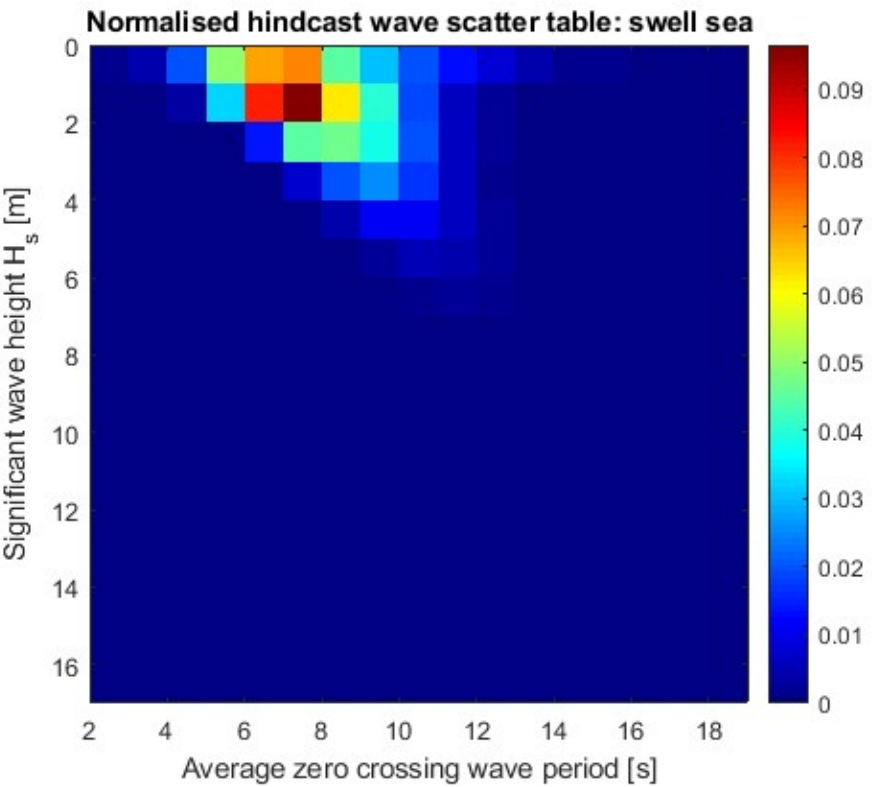
Figure 6. Hindcast WST for swell sea (sea area S—full year).